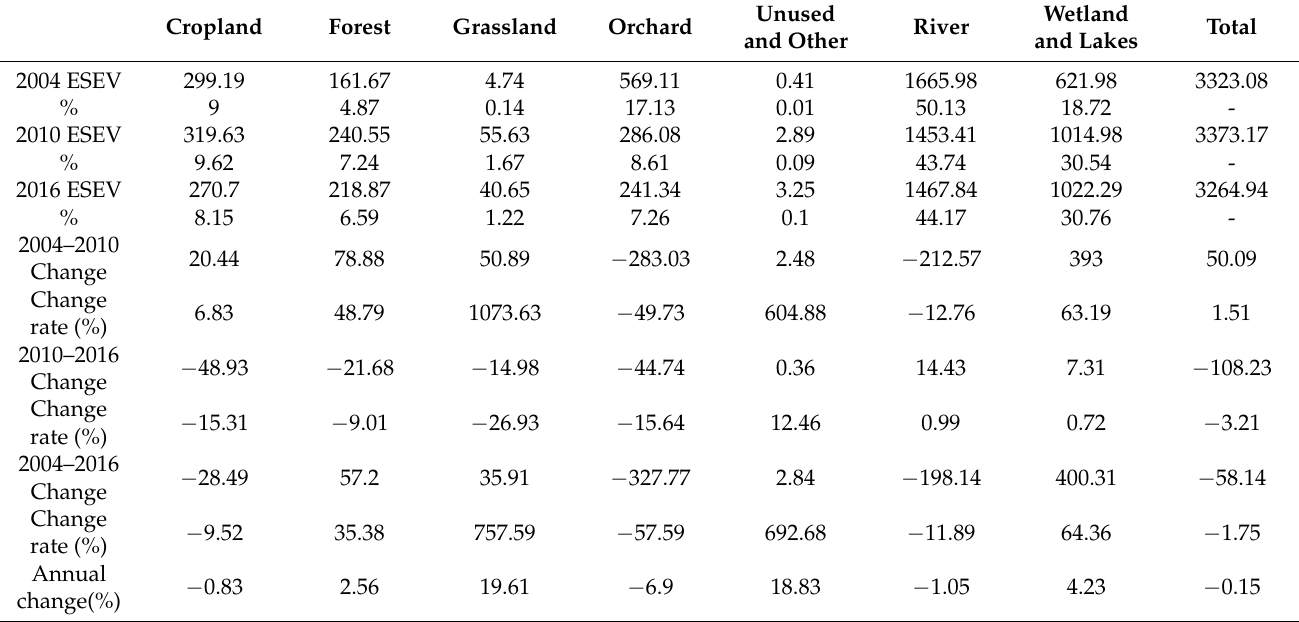
Table 7. The total ESEV of each land use and its changes (1000 ESEV).